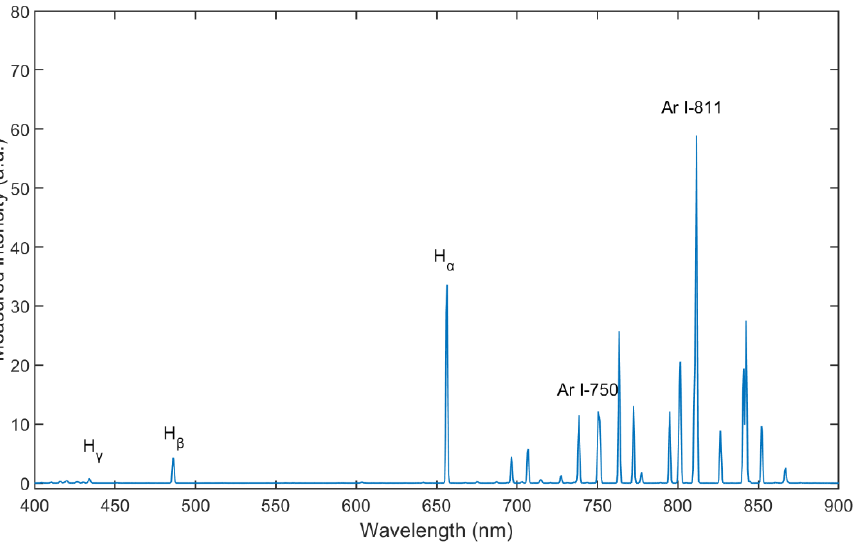
Figure 4. Optical emission spectra of Ar/H 2 ICP (with 35% hydrogen, at pressure of 5 Pa and power of 165 W).